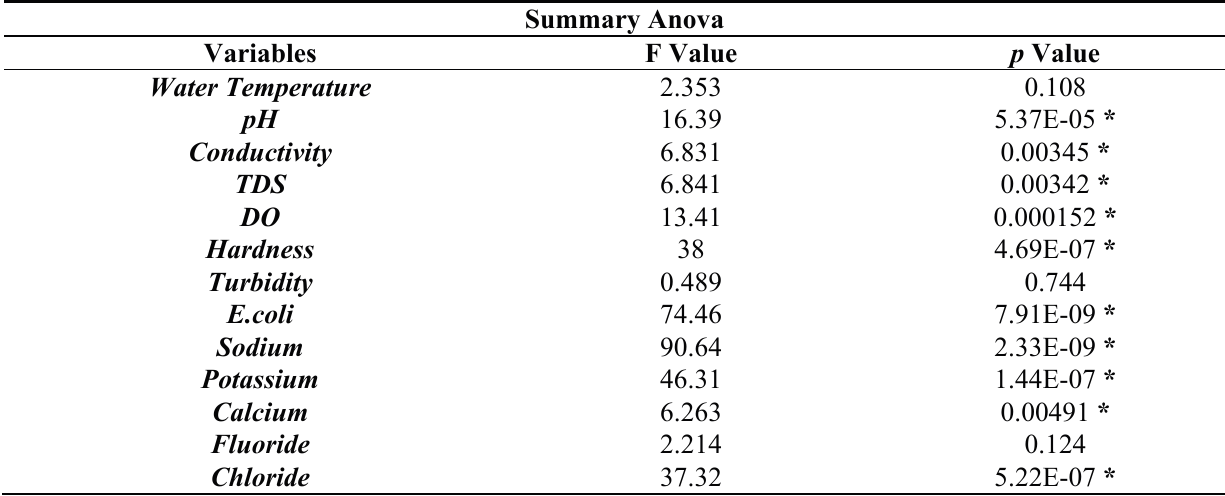
Table 6. Analysis of variance of means for variables between the sampling points (Points 1, 2, 3, 4 and